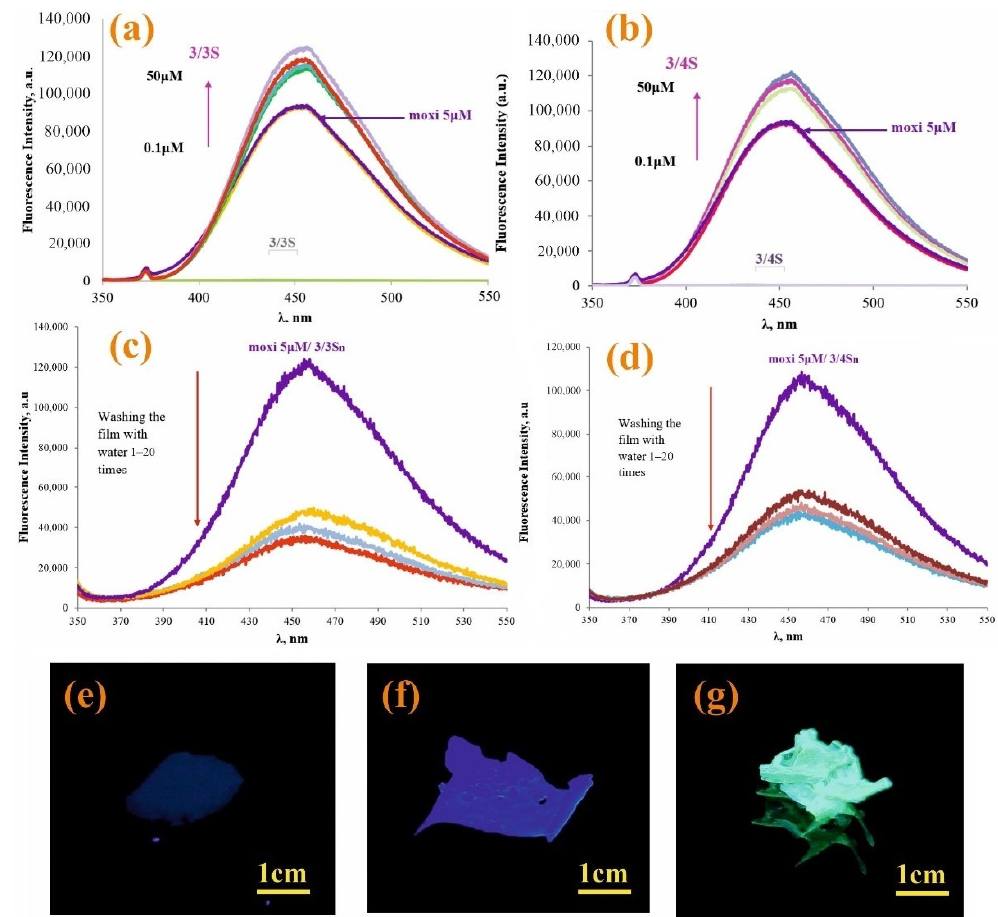
Figure 3. Fluorescence spectra of moxi (5 × 10 − 6 M) with various concentrations of: ( a ) 3/3S (0–50 µ M) and ( b ) 3/4S (0–50 µ M); ( c ) fluorescence spectra 3/3Sn /moxi and ( d ) 3/4Sn /moxi of the film before and after washing with distilled water; photographs of samples under UV irradiation at λ = 365 nm ( e ) 3n ; ( f ) 3/4Sn ; and ( g ) 3/4Sn + moxi after washing with water (five times).